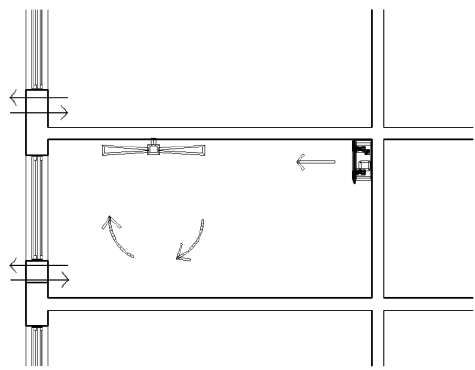
Figure 1. Concept diagram of proposed ventilation strategy.